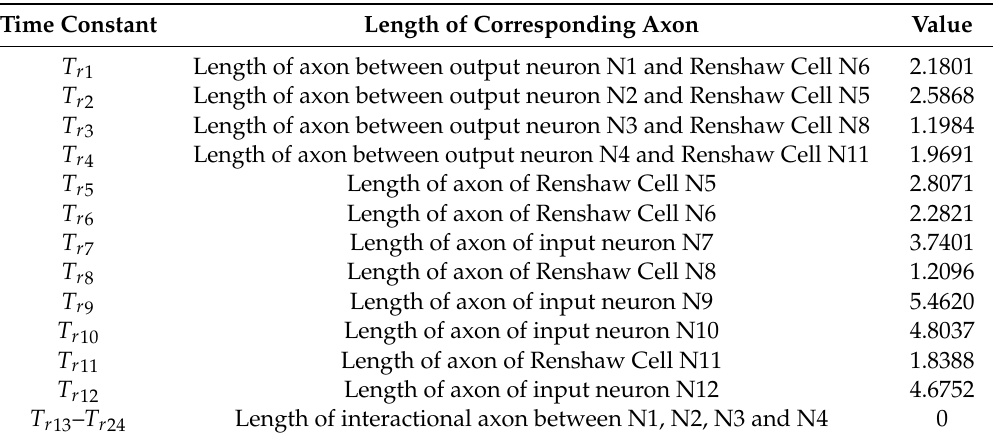
Table 1. The time constant of the axon in the network.